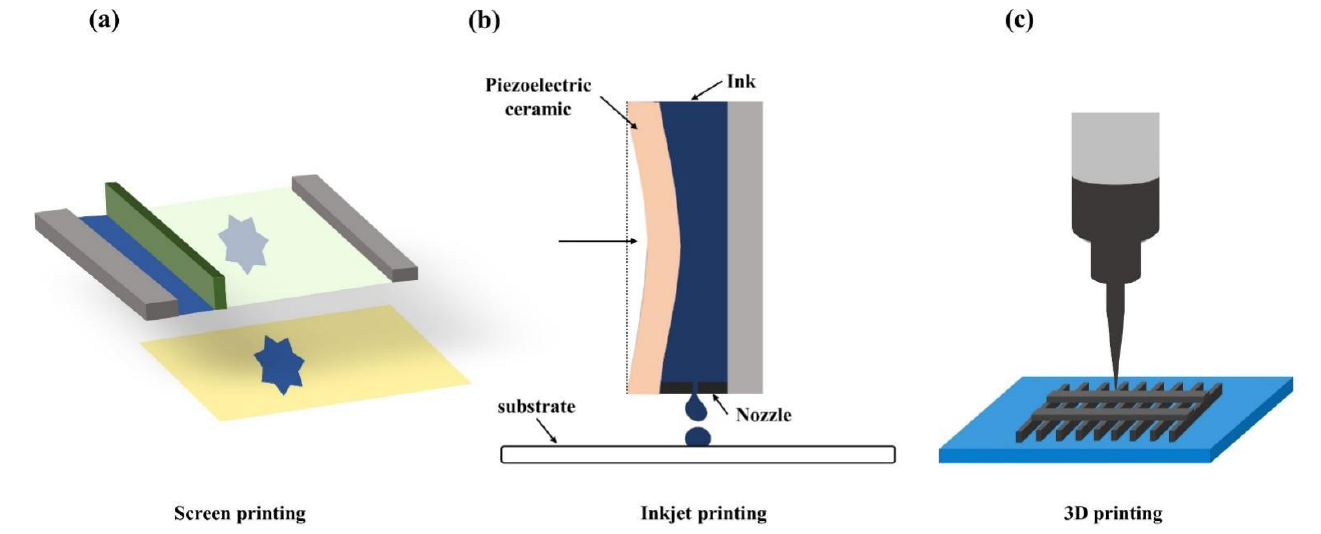
Figure 9. A visual summary of printing technology. ( a ) Screen printing: the ink is transferred to the sublayer with the mask. ( b ) Inkjet printing: deformation extrusion is generated by piezoelectric crystals to squeeze the ink in the nozzle. ( c ) 3D printing: the material is printed out of a three-dimensional object by a printing device.